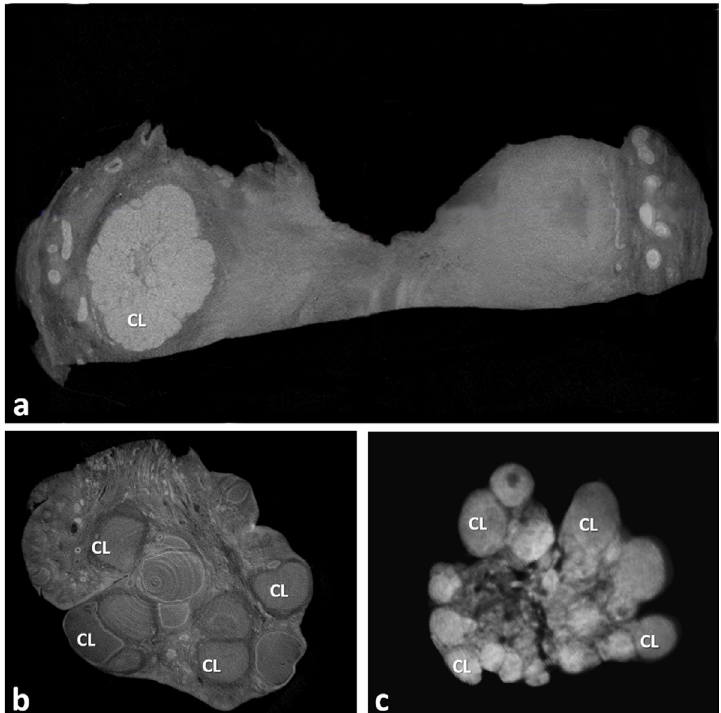
Figure 5 - MicroCT image obtained using the contrast tool ( DataViewer software) that permits a better view of corpus luteum in the ovary. a: mare. b: sow. c: rat. CL: corpus luteum. Barr = 2.5 mm.